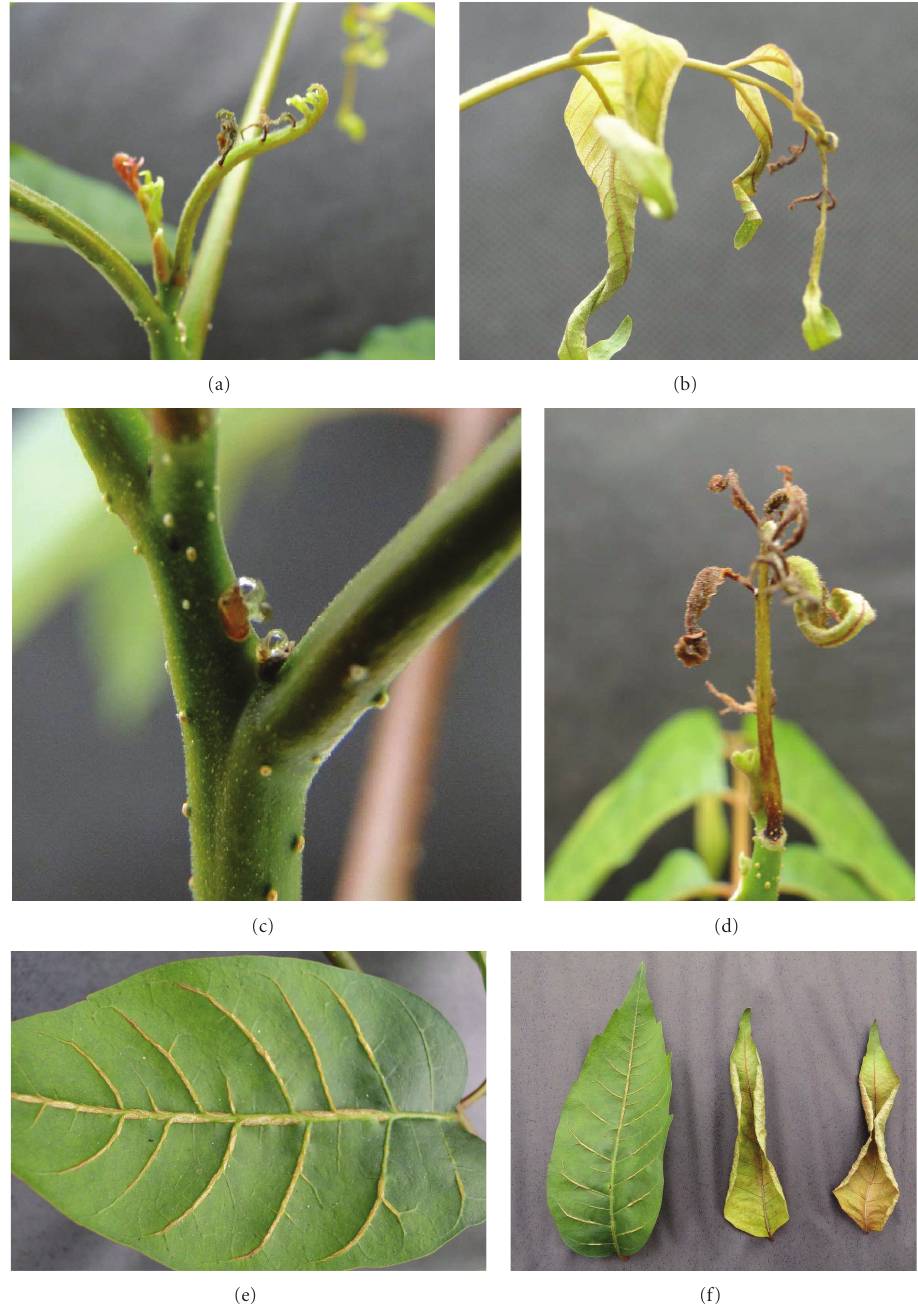
Figure 4: Symptoms of boron deficiency in Australian Red Cedar seedlings. Death and fall of young leaves ((a) and (b)), gum exudation (c), death of apical bud (d), slits along the leaf veins (e), and progress of the symptom in the leaf